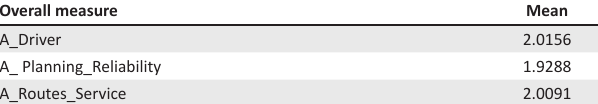
TABLE 13: Means of overall